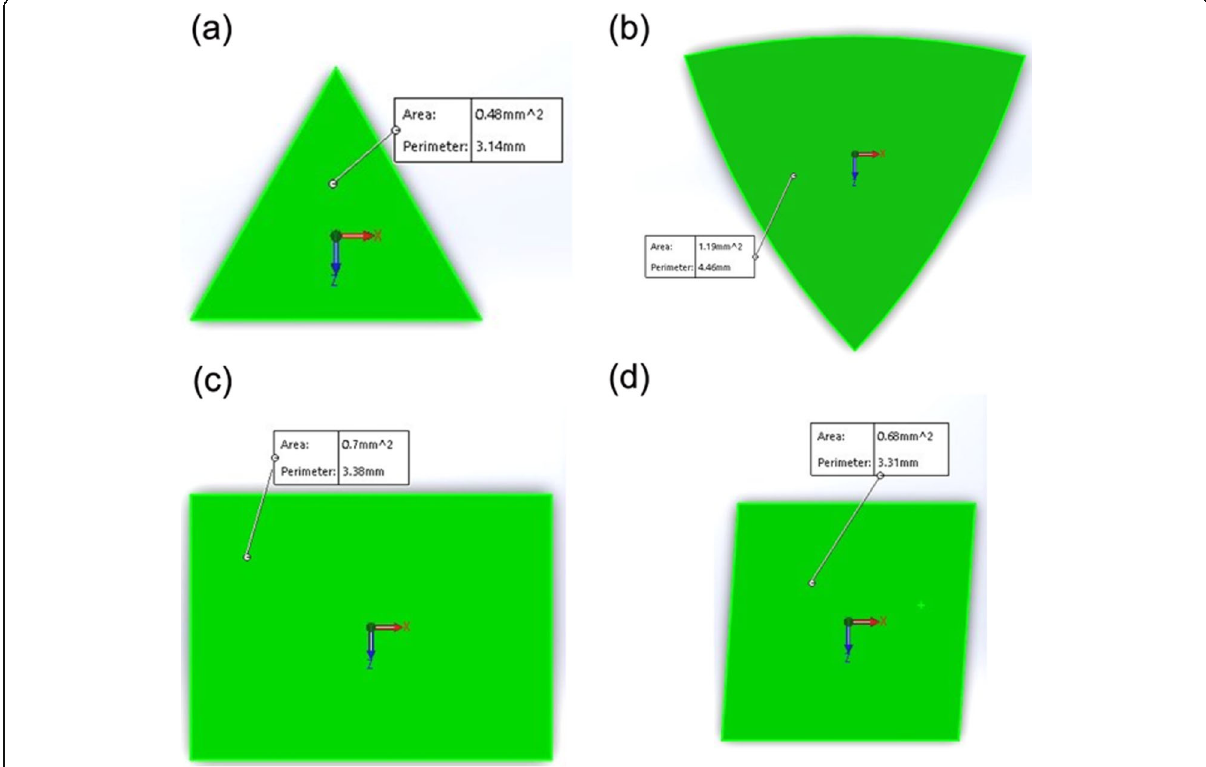
Fig. 2 A 2D drawing of different designed file cross section. a Triangle cs. b Convex triangular cs. c Rectangle cs. d Parallelogram